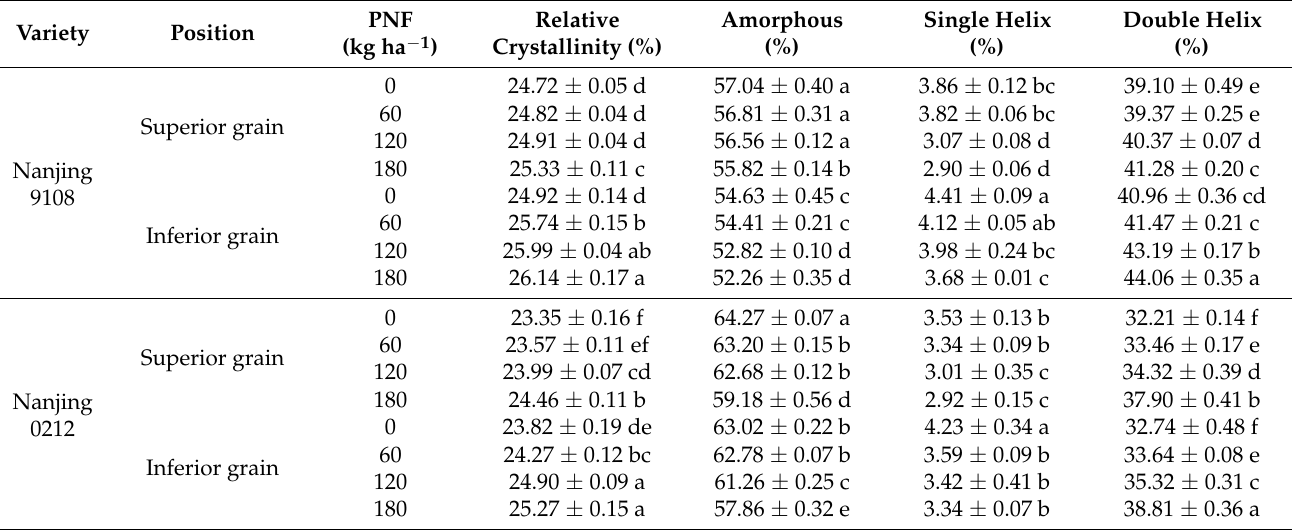
Figure 3. XRD patterns ( A , B ) and NMR ordered sub-spectra ( C , D ) of superior and inferior grains of japonica rice under different PNF treatments. Table 5. Relative crystallinity, amorphous region, contents of single helix and double helix of superior and inferior grains of japonica rice under different PNF